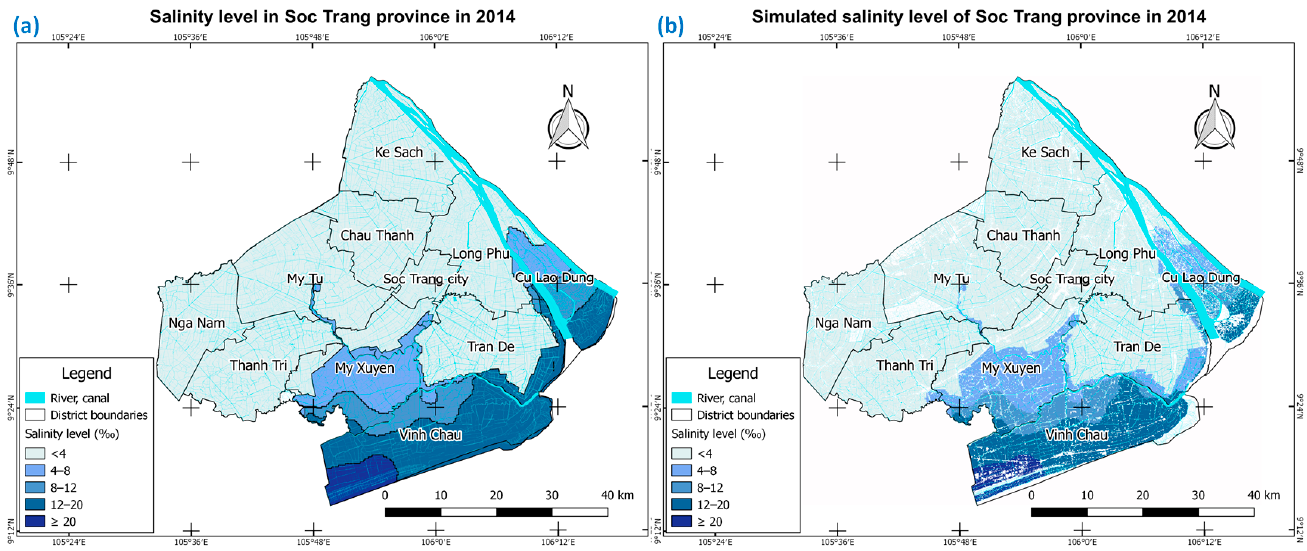
Figure 6. Salinity diffusion in Soc Trang province. ( a ) Salinity map in 2014; ( b ) Simulated salinity in 2014.